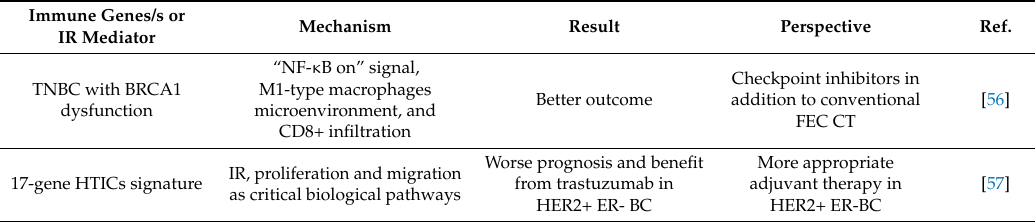
Table 3. The Immune System and Prognosis or Prediction of Response to